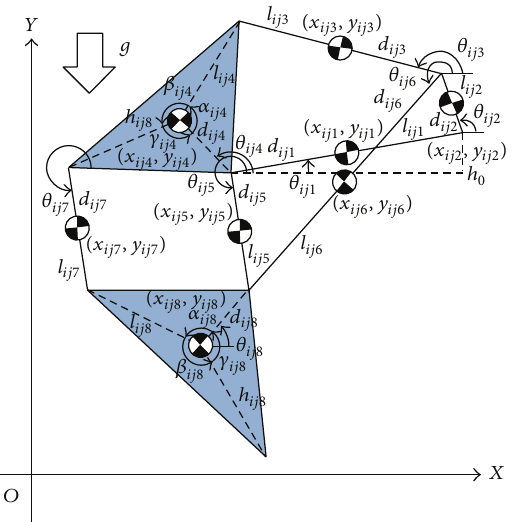
Table 3: The lengths of links adopted for the Theo Jansen linkage mechanism of this